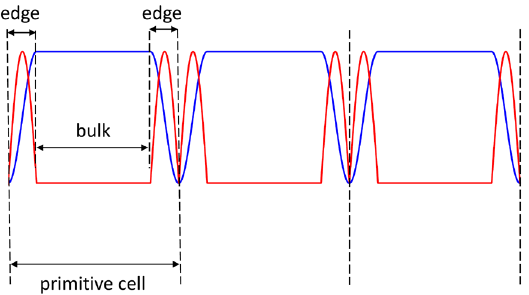
Figure 14. Illustrative sketch of a possible continuous (w → 0) periodic undulation of the magnetization M x ( x ) (blue line) superposed to the corresponding divergence (absolute value, red line), showing the occurrence of distinct bulk/edge regions (indicatively) for localization of spin wave amplitude within the cell wavefunction. The peaks of the divergence correspond to the minima of the internal effective